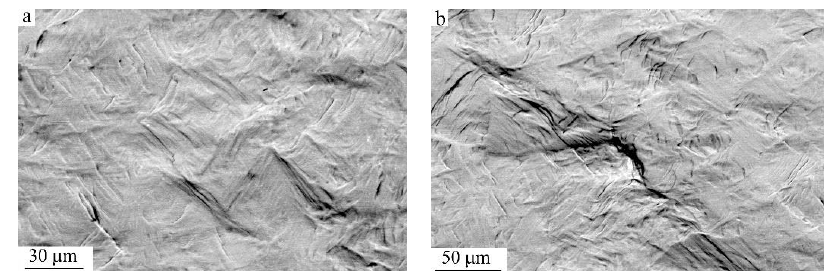
Fig. 3. SEM images of the surface of SLM Ti–6Al–4V samples subjected to uniaxial tension for  =7 %.